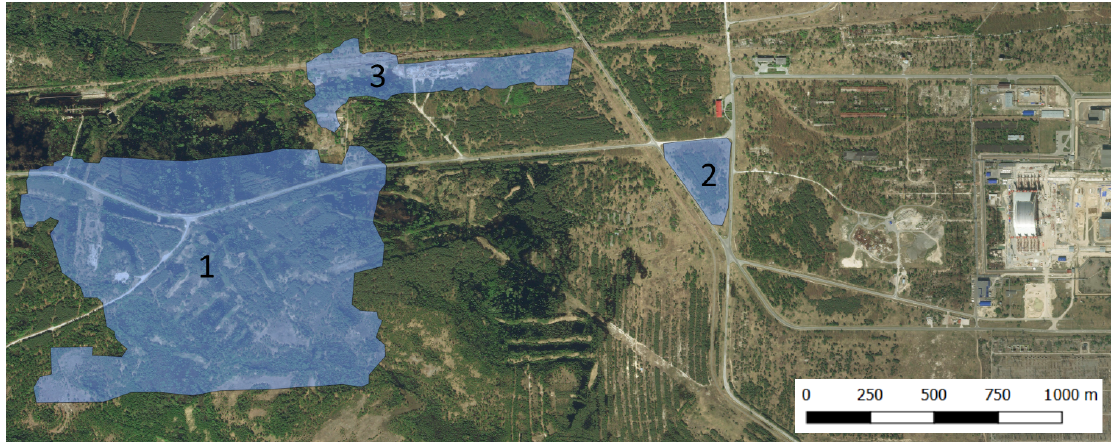
Figure 2. Locations of the three study areas in the ChEZ (source: bing map ©Microsoft